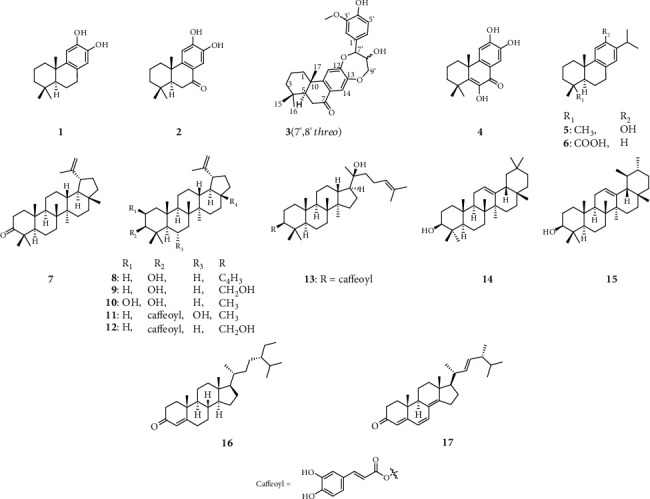
Chemical structure of compounds 1–17.